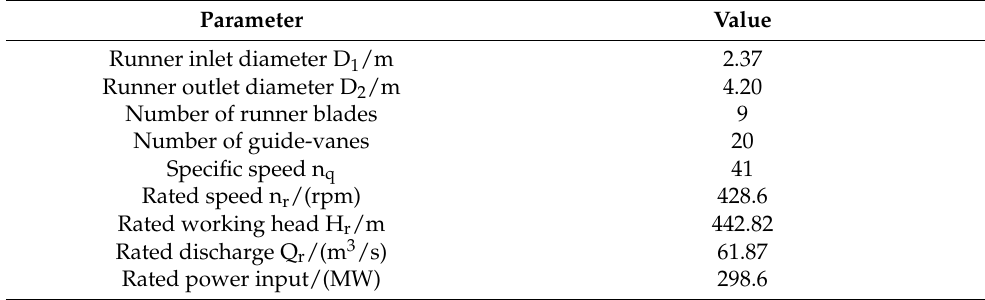
Table 1. Main parameters of the prototype pump-turbine operated in pump mode.